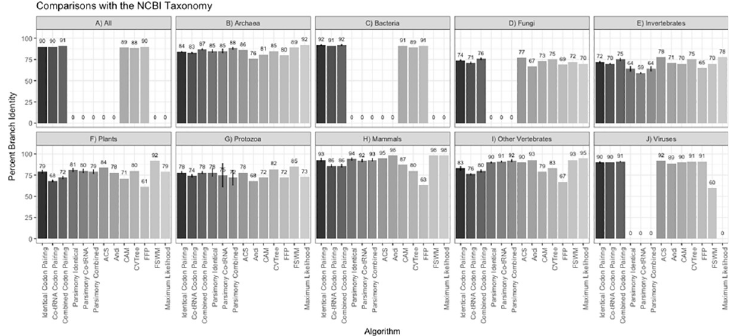
Fig 2. Percent edge overlap for comparisons of each algorithm against the NCBI taxonomy. The alignment-free and parsimony codon pairing methods report the mean percent edge overlap with the NCBI taxonomy based on using different ribosome windows from 2–11. Error bars are reported for the codon pairing methods, signifying one standard deviation from the mean. The other methods were previously reported in Miller, McKinnon [12] and are used for